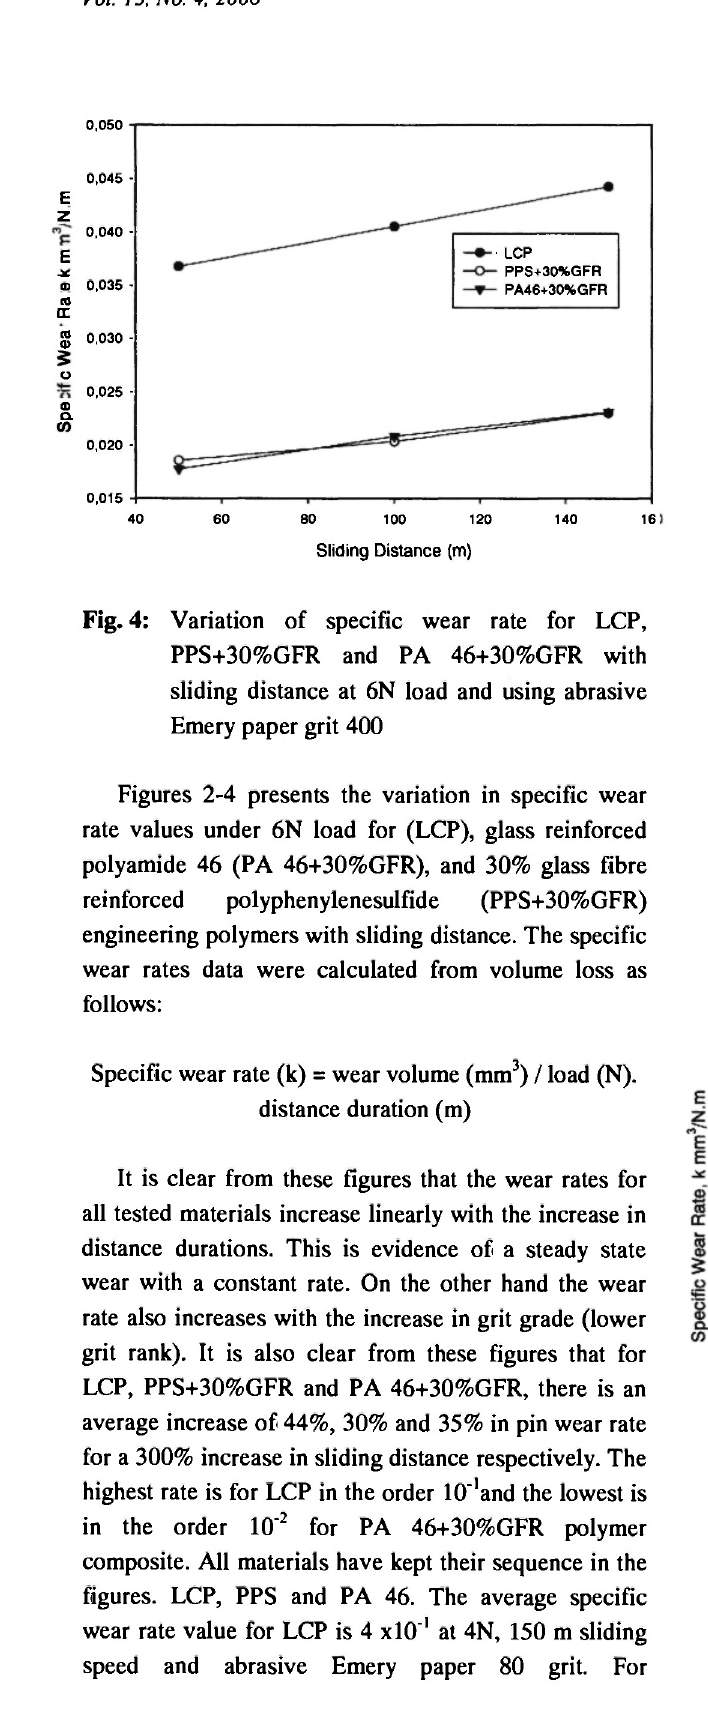
Fig. 5: Variation of specific wear rate for LCP, PPS+30%GFR and PA 46+30%GFR with applied load for 150m sliding distance